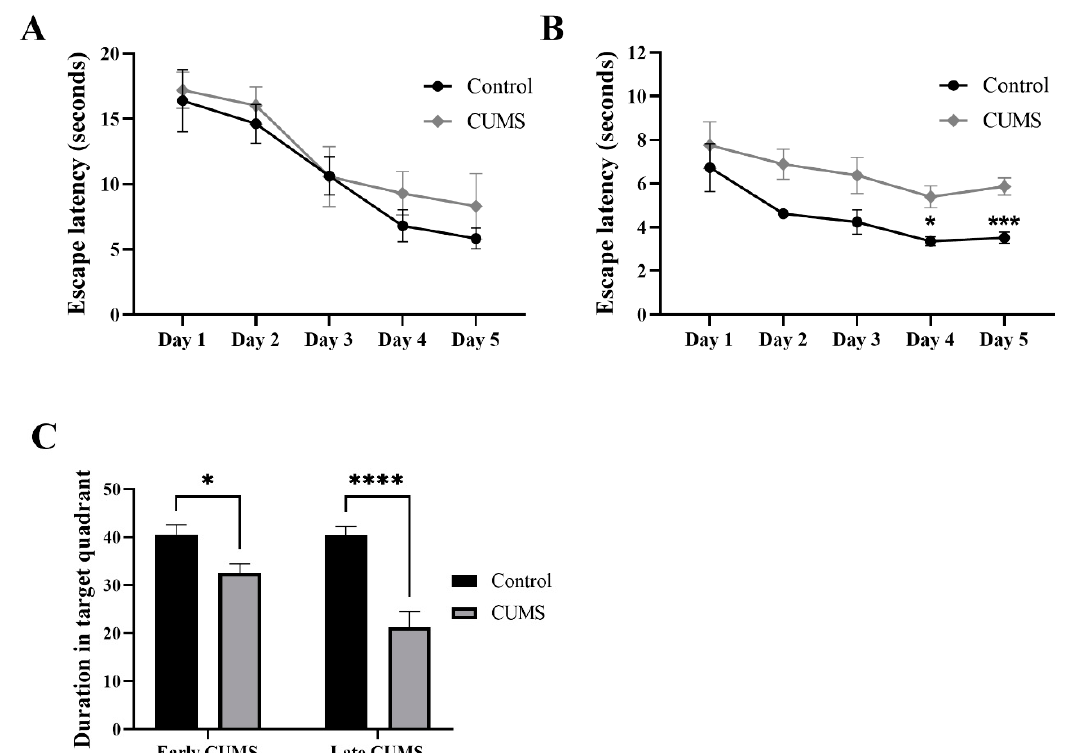
Figure 7. The effect of CUMS on long-term spatial memory in the MWM task. The effect of early ( A ) and late ( B ) CUMS on escape latency time and ( C ) probe test. Two-way ANOVA was used, followed by Šídák’s multiple-comparisons test. (*) indicates a significant difference between the CUMS and the control group at p > 0.05, *** p < 0.001, and **** p < 0.0001.